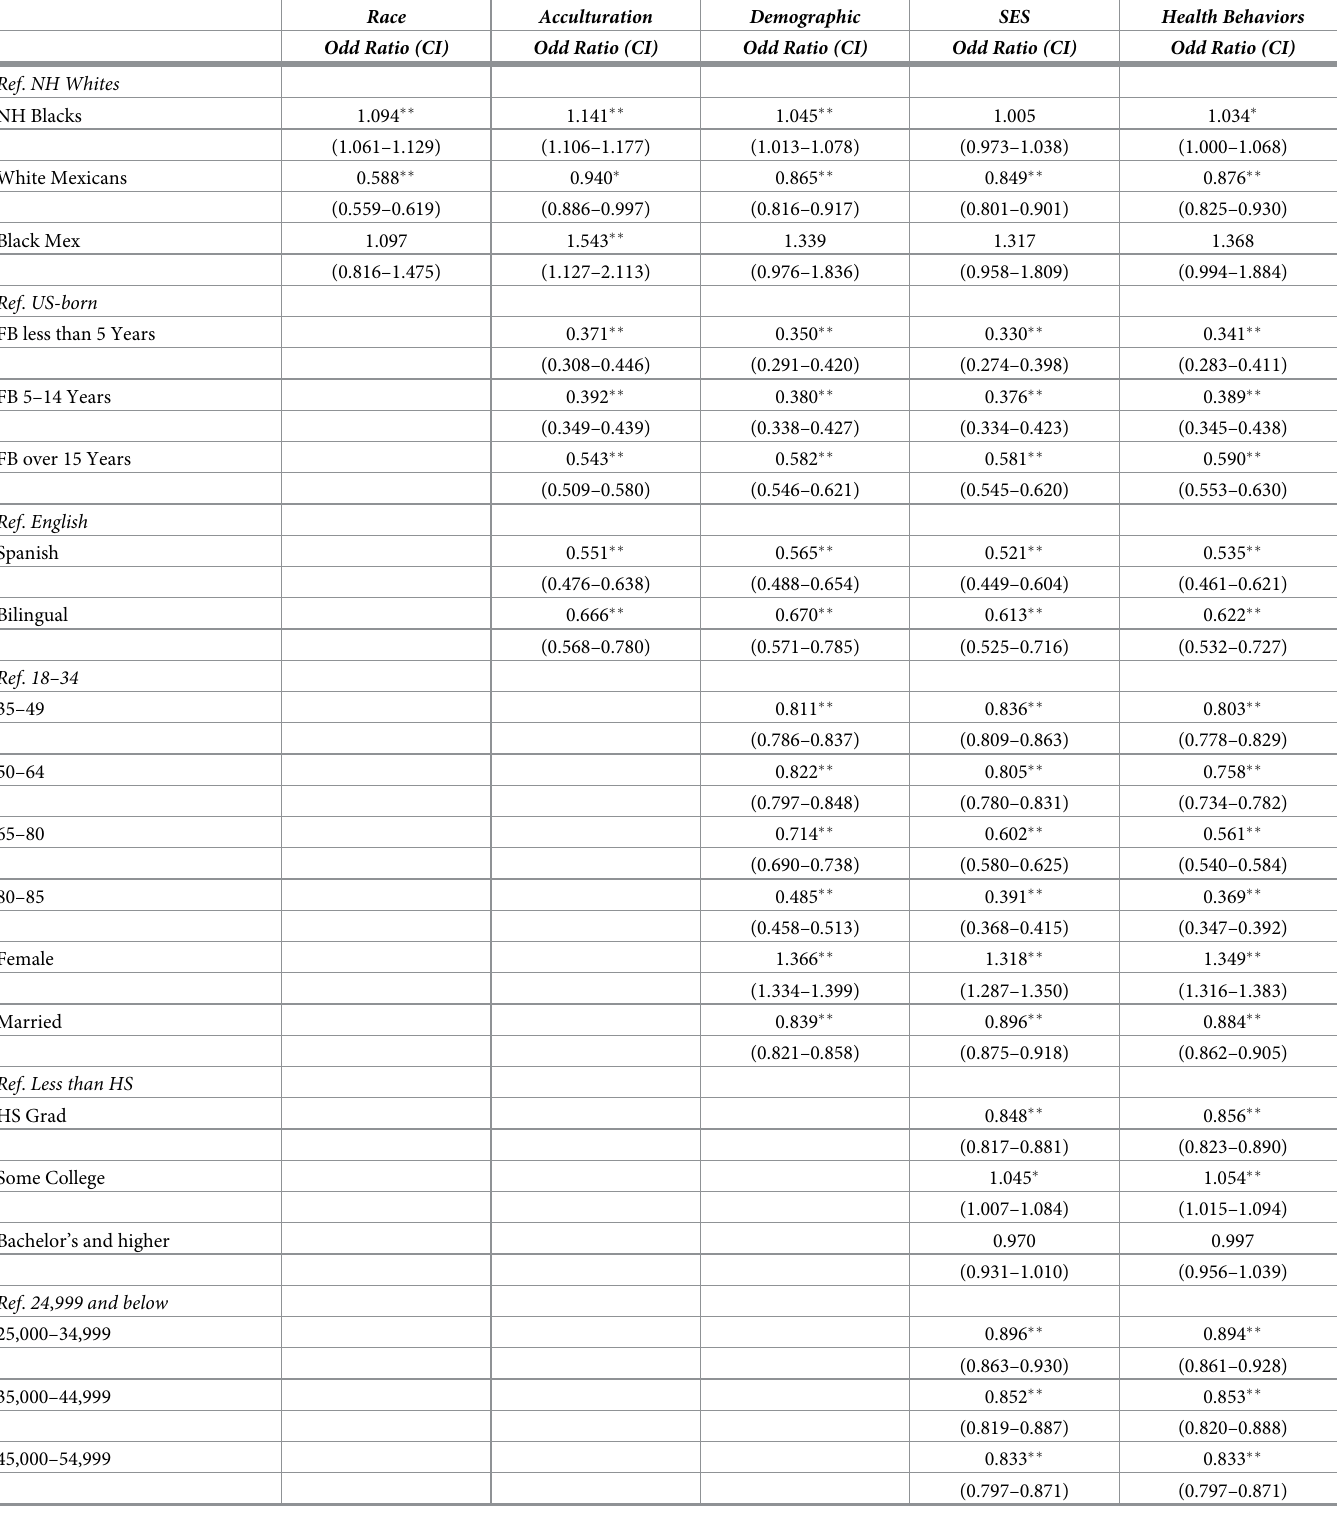
Table 2. Logistic models of asthma controlling for race/ethnicity, acculturation, demographic, socioeconomic, and health behavior